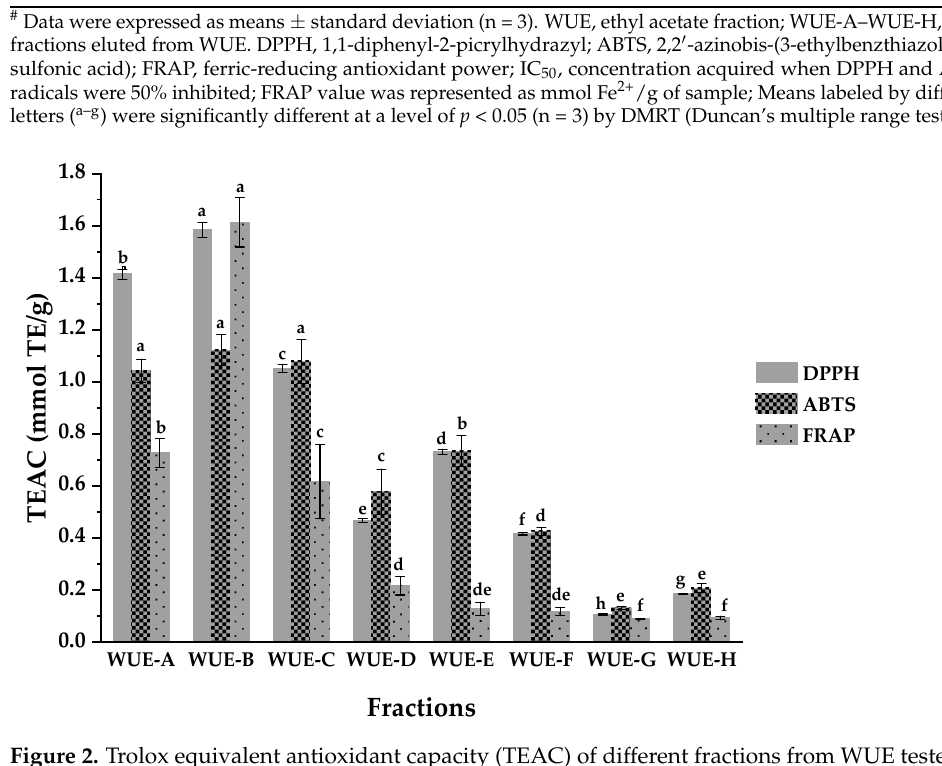
Table 2. Antioxidant activities of different fractions eluted from WUE tested by DPPH, ABTS, and FRAP assays.